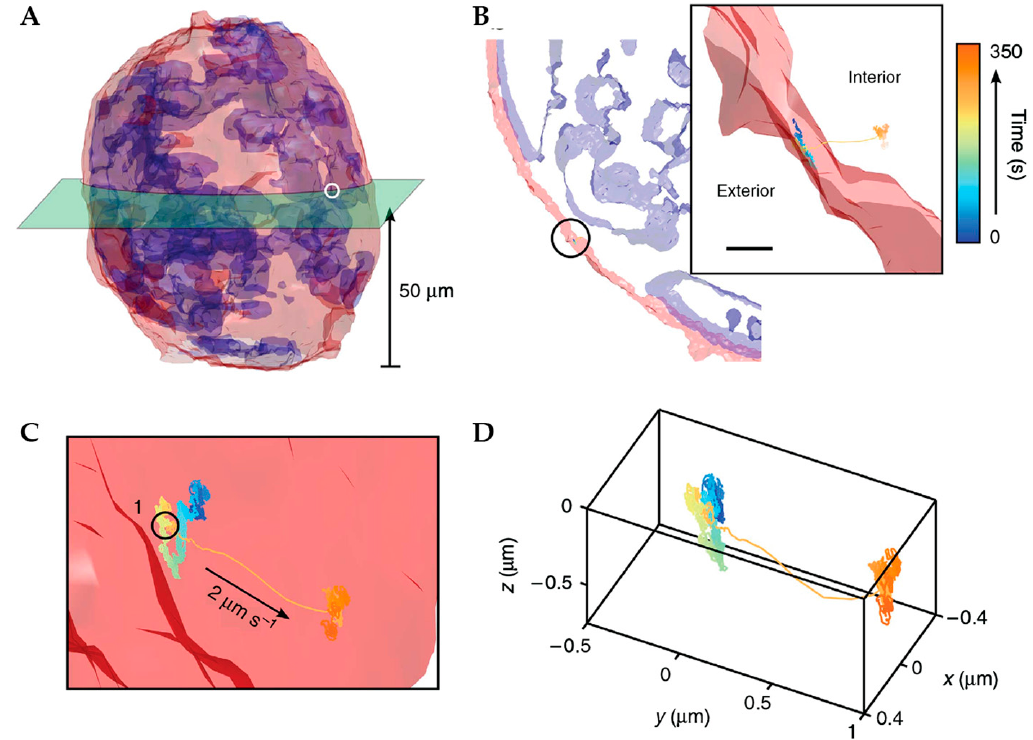
Figure 12. Prior volumetric imaging combined with TSUNAMI-based tracking was used to acquire a volumetric image of the entire 100 µm diameter tumor spheroid around an internalizing particle. ( a ) 3D isocontour reconstruction of tumor spheroid with red plasma membrane and blue nucleus. Green section at 50 µm shows plane of EGFR internalization trajectory. ( b ) Isocontour model of the green slice in (a). Inset shows zoomed in view highlighting spheroid boundary and the placement of the trajectory as it transports into the spheroid. ( c ) Zoom in ( b ). ( d ) Isolated trajectory. Adapted from